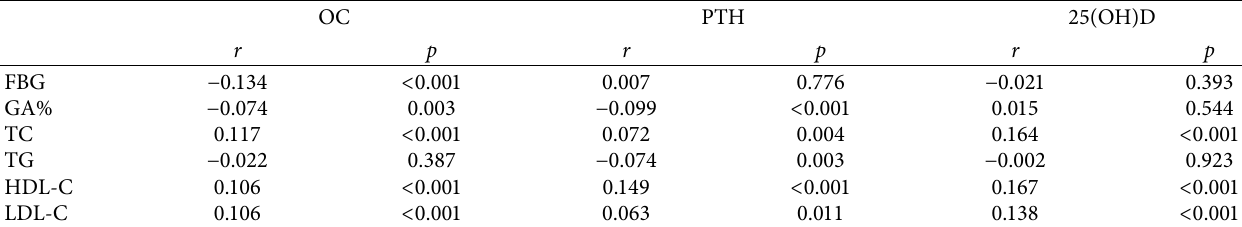
Table 2: Correlations between osteocalcin, calciotropic hormones, and glucose/lipid metabolic parameters. OC PTH